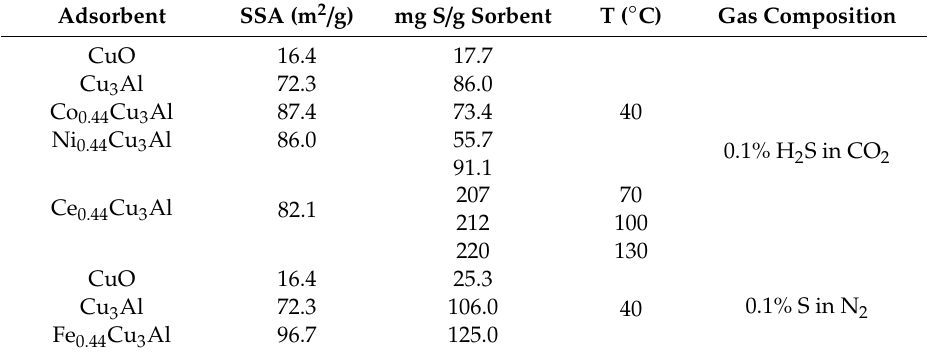
Table 4. Brunauer–Emmet–Teller (BET) surface areas and breakthrough capacity in mixed copper–based metal oxides, prepared via co–precipitation, for H 2 S adsorption (adopted from [123]). SSA: specific surface